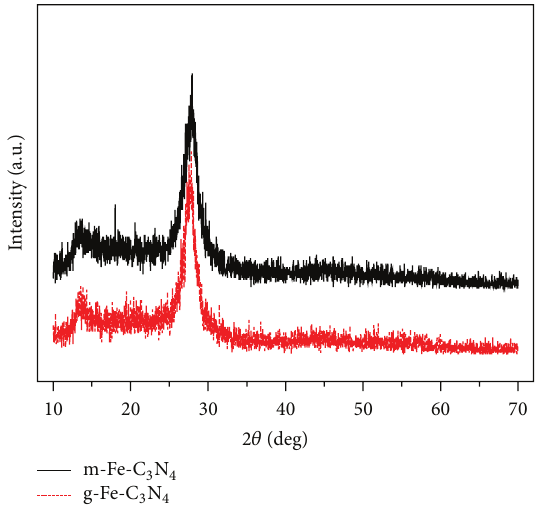
Figure 1: XRD patterns of the g-Fe-C 3 N 4 and m-Fe-C 3 N 4